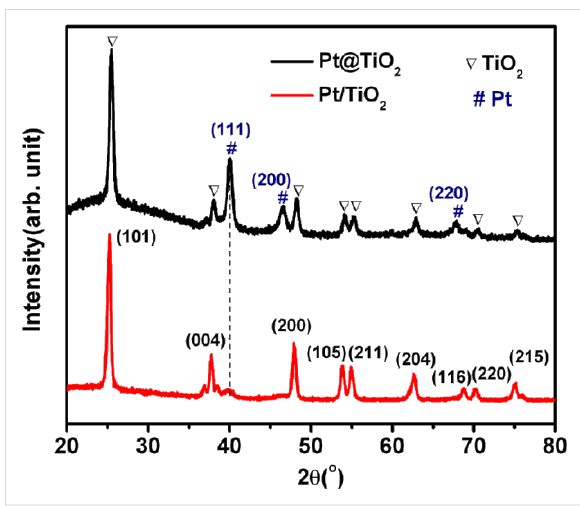
Figure 1: XRD patterns of Pt@TiO 2 and Pt/TiO 2 samples.